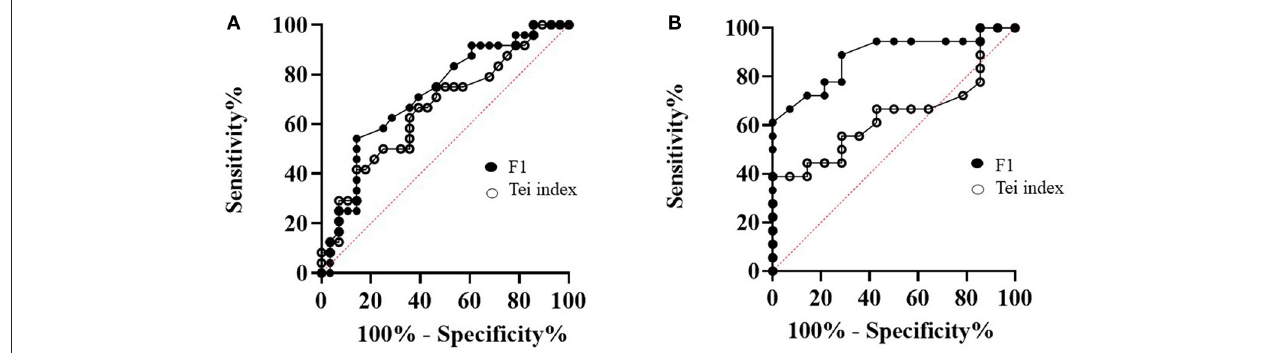
FIGURE 7 | A comparison of the receiver operating characteristic (ROC) curves of MPI-F1 and Tei index between asymptomatic and symptomatic MMVD dogs (A) and B1 and C MMVD dogs (B) . MPI, myocardial performance index; MMVD, myxomatous mitral valve